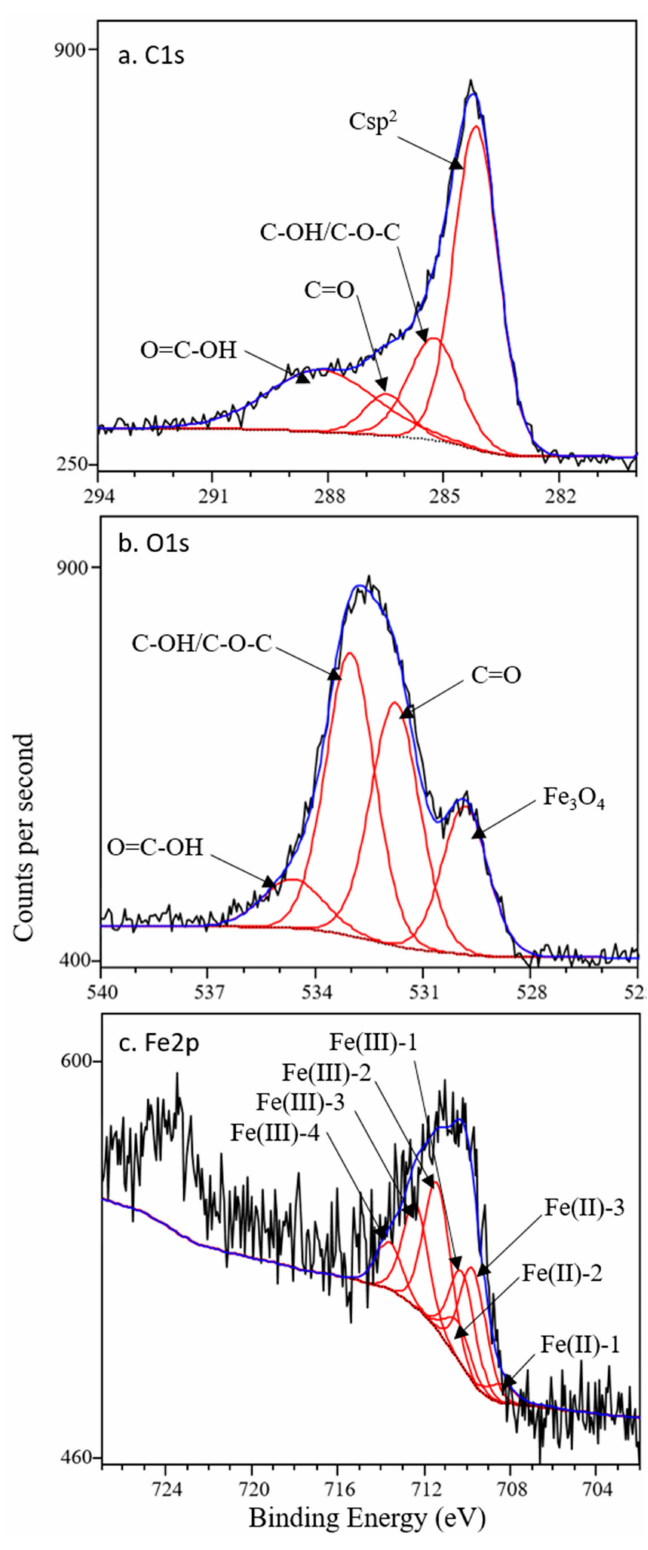
Figure 3. XPS spectra of BC-Mag particles, ( a ) C1s, ( b ) O1s, ( c ) Fe2p. Black lines are measured data, red lines are modeled peaks, and blue lines are overall model